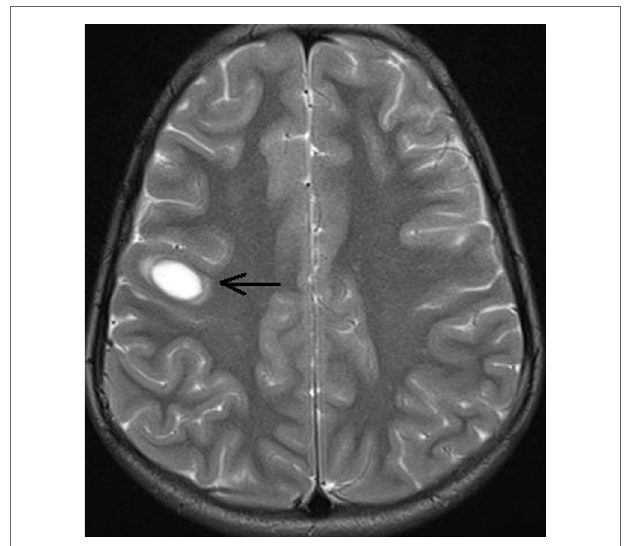
FIGURe 2 | MRI screening of brain showing single focal well-circumscribed hyperintense lesion (arrow) in t2 sequence at right subcortical frontal region (at gray white interface) .